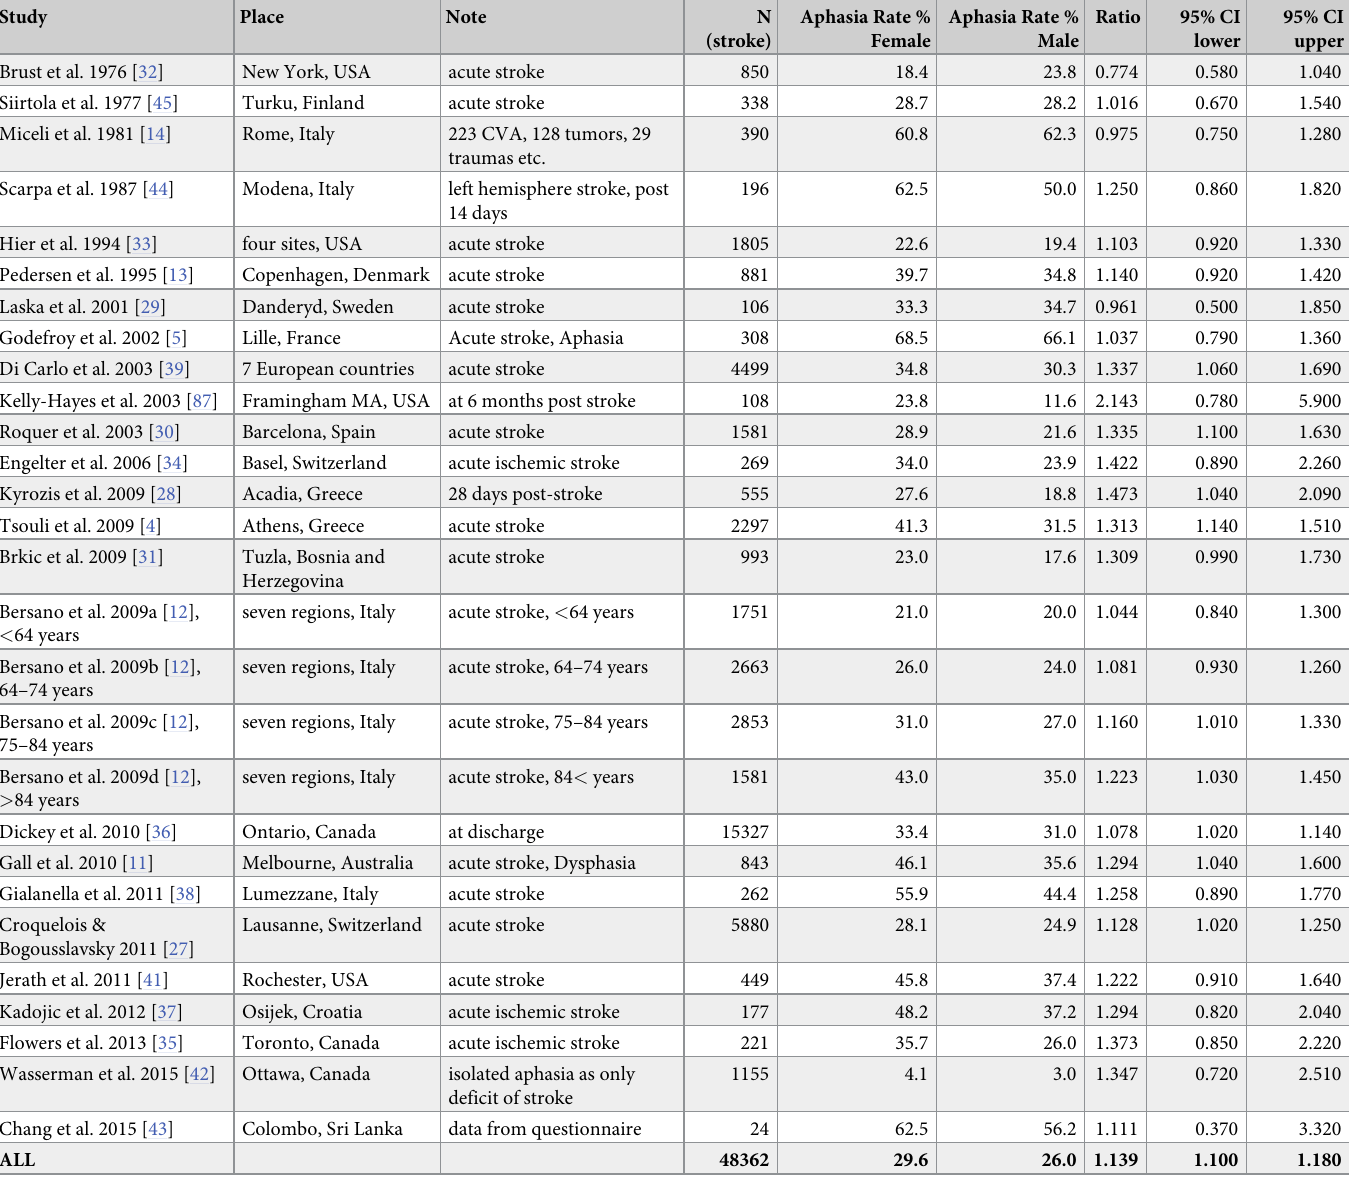
Table 1. Studies included in the meta-analysis by publication